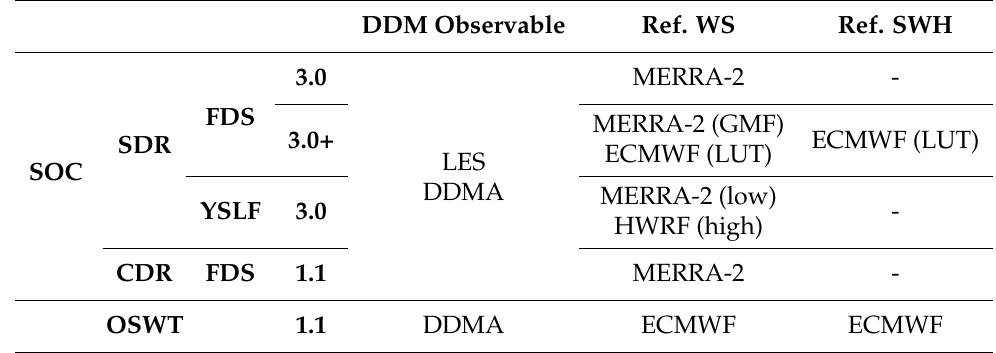
Table 2. Summary of the different CYGNSS wind products showing the DDM observables and the reference data used to build